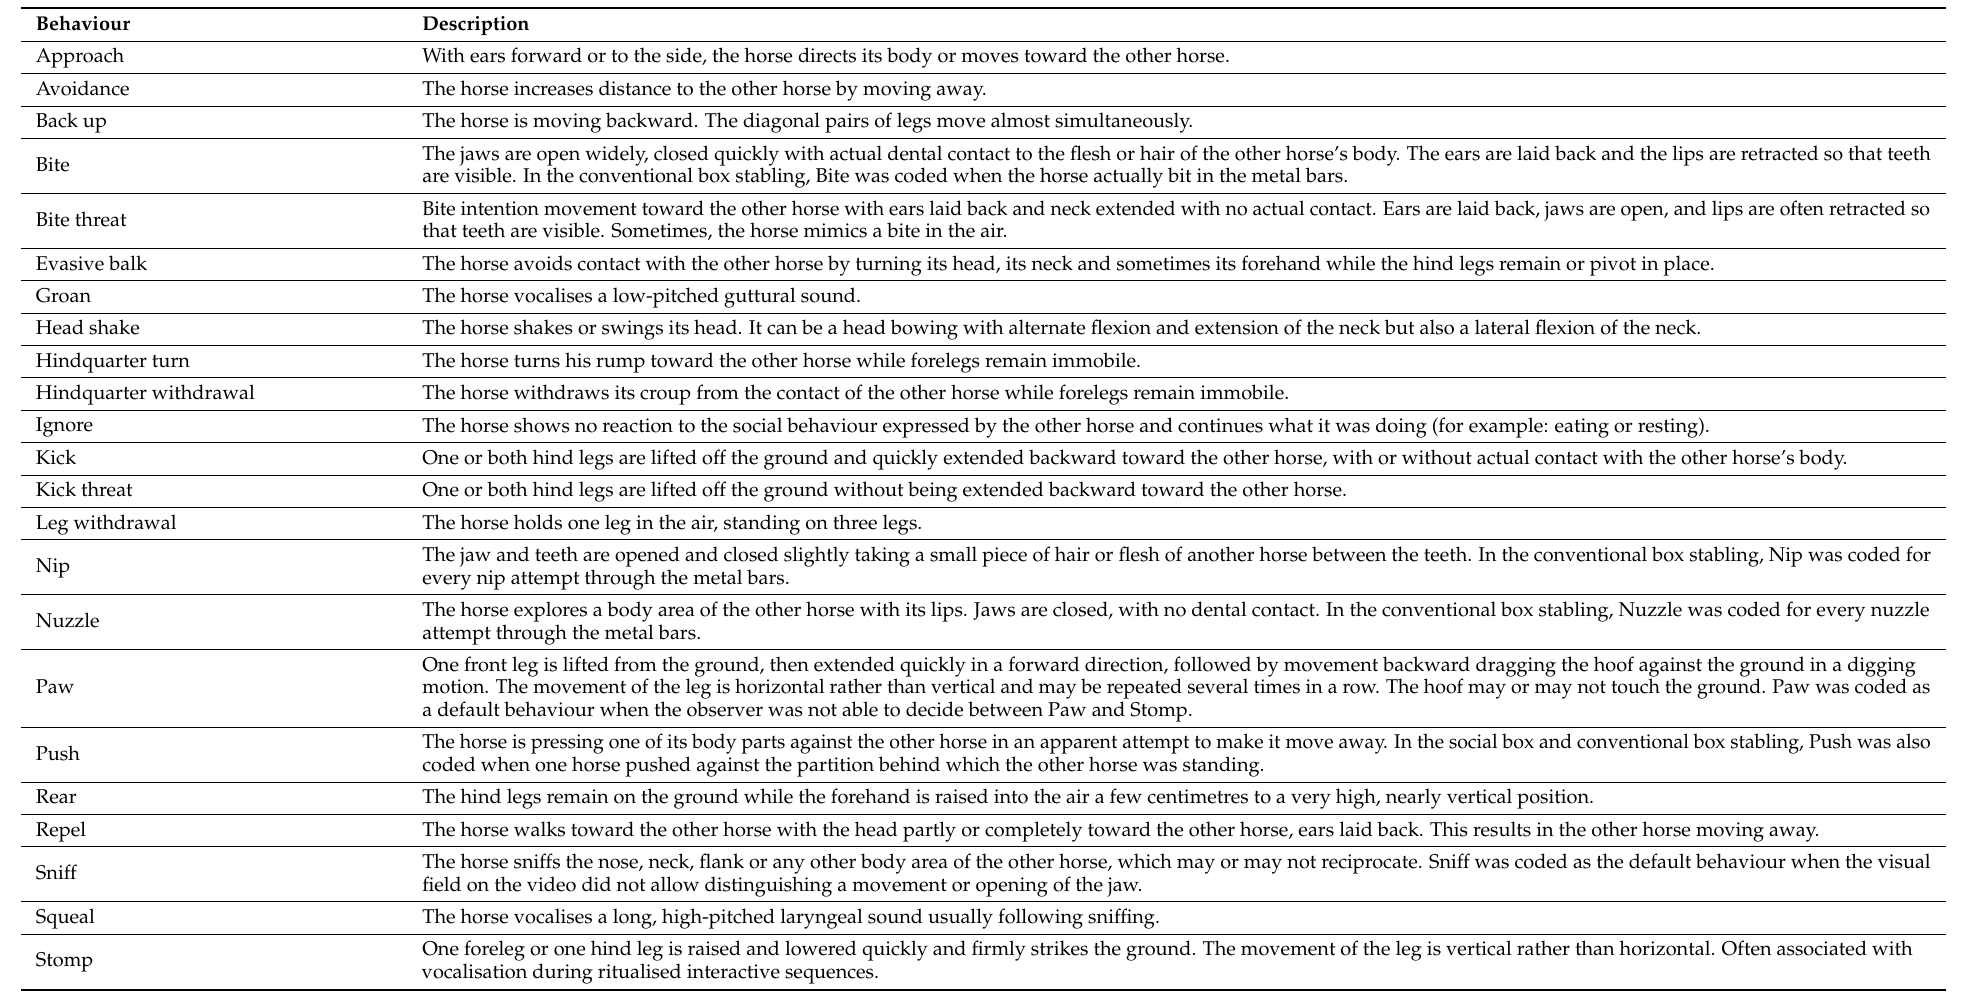
Table 1. Ethogram of social behaviour recorded as point behaviour, adapted from [2,4,7,32]. Behaviour